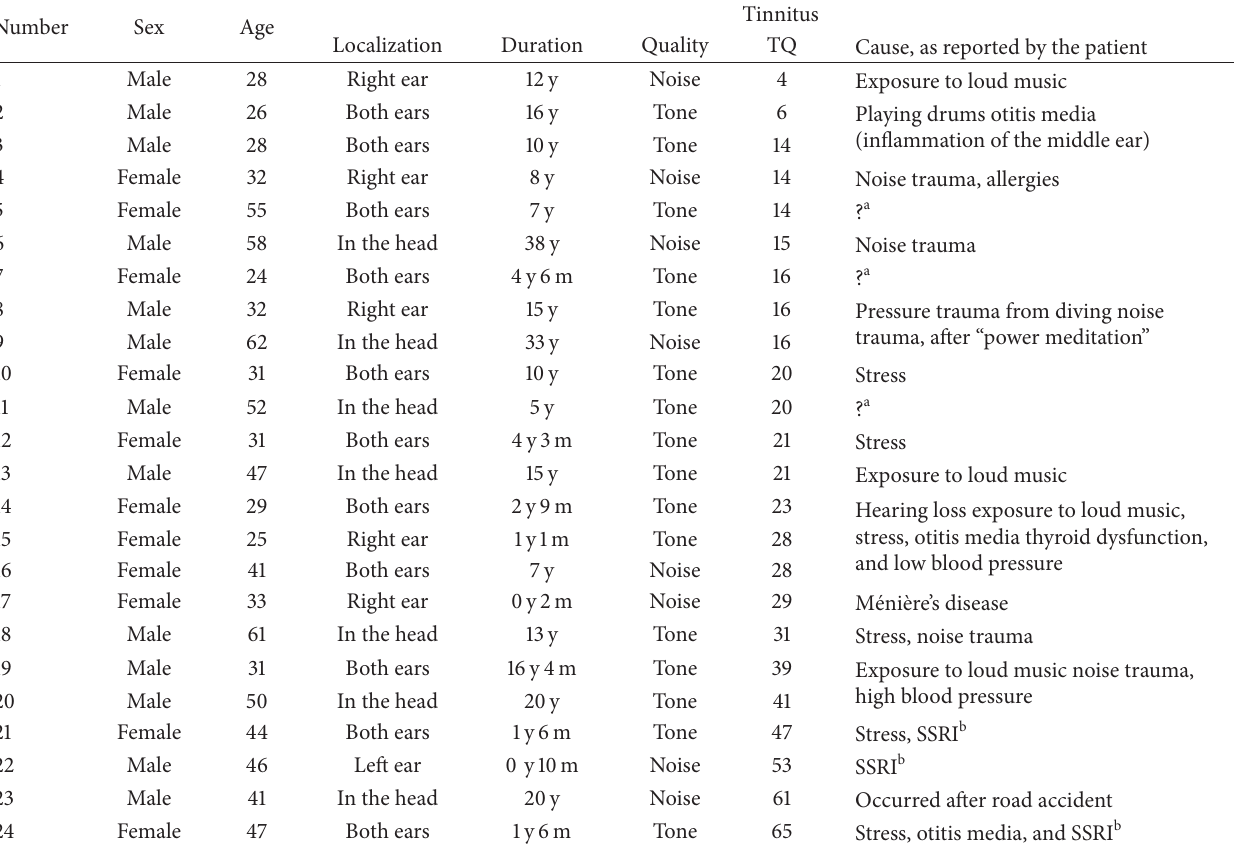
Table 1: Demographics and clinical details of the patient group.